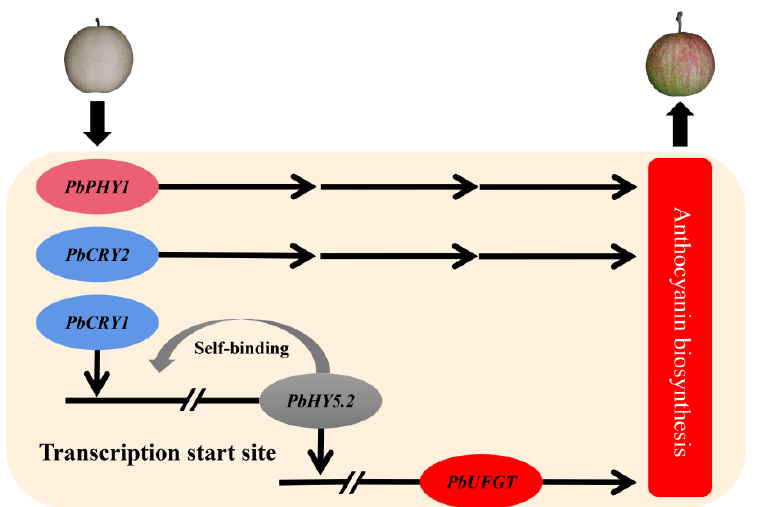
Figure 8. Model for the regulation of light-induced anthocyanin biosynthesis in fruit of ‘Xinqihong’ pear .